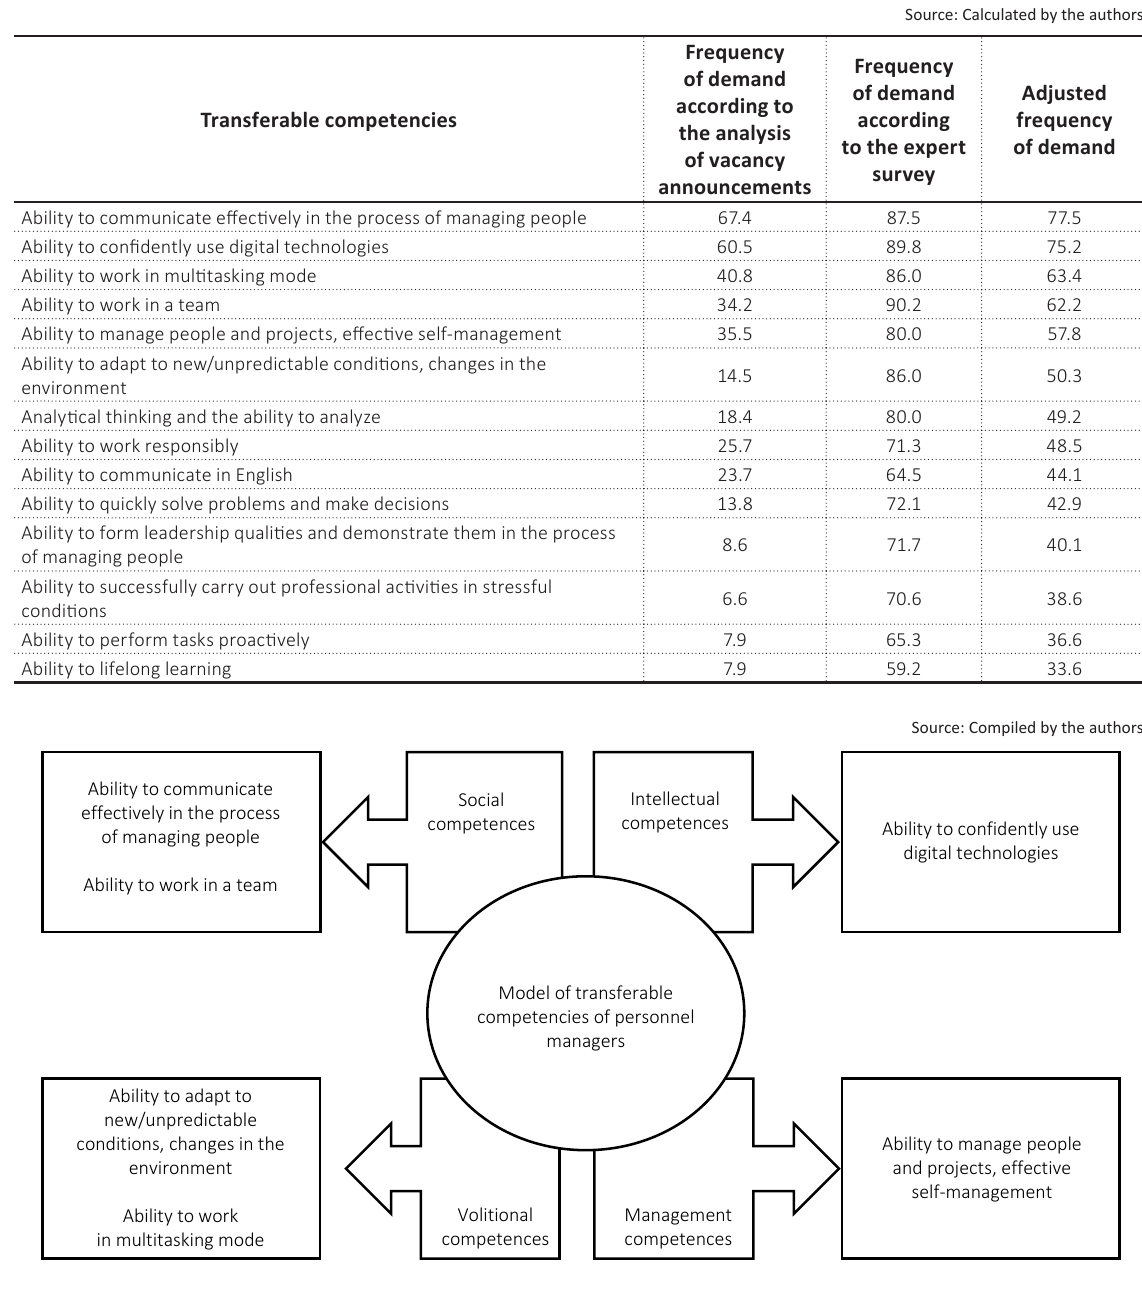
Table 3. Frequency of demand for transferable competencies of personnel managers among employers of Ukraine, %